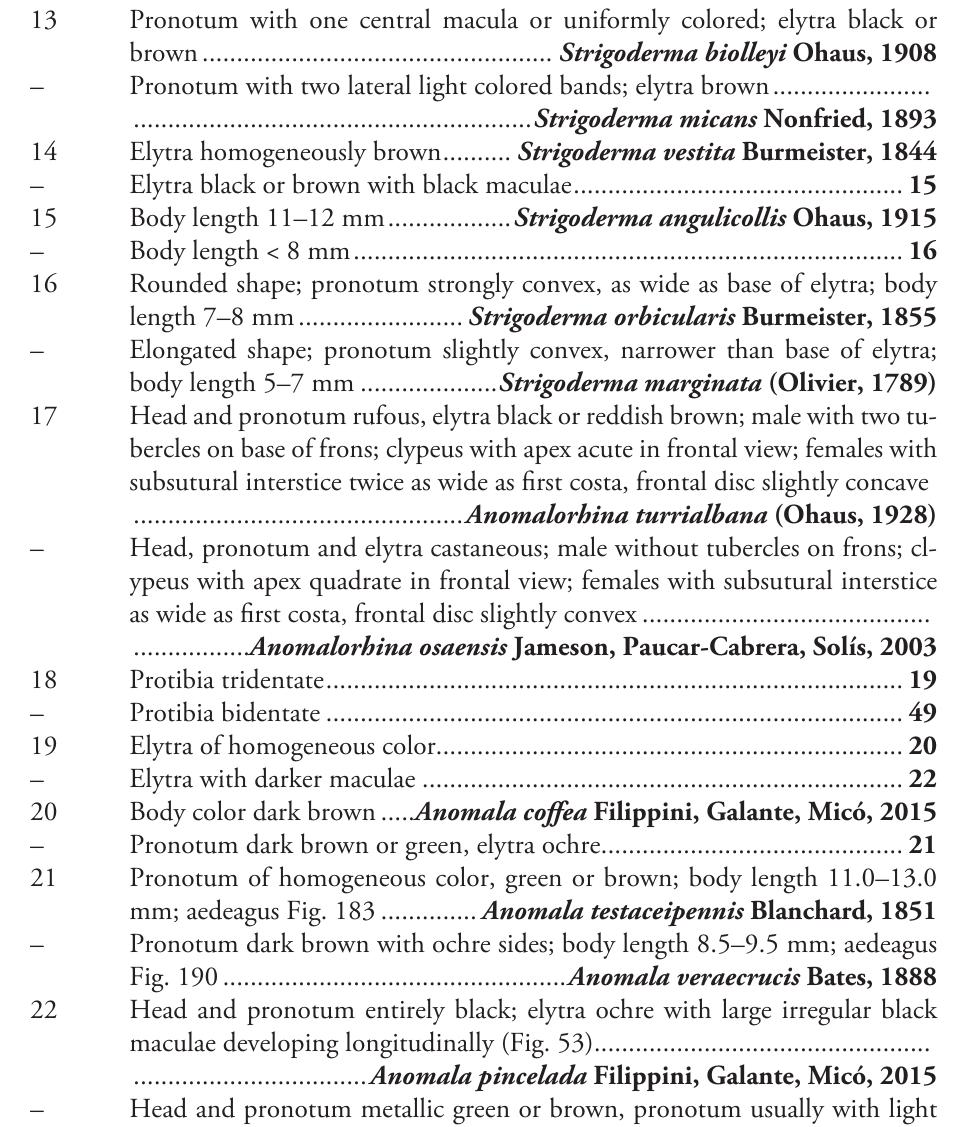
– Head and pronotum metallic green or brown, pronotum usually with light colored margins; elytra with small maculae on transversal bands or sparse 23 Pattern on elytra consists of one central macula or median transversal band .... 24 – Pattern on elytra consists of various bands of maculae or sparse flecks ...... 25 24 Pronotum mainly dark brown with narrow ochre sides; body length 10–12 mm; – Pronotum with pentagonal central dark macula, less than half the pronotum width; body length 8–10 mm; aedeagus Fig. 131